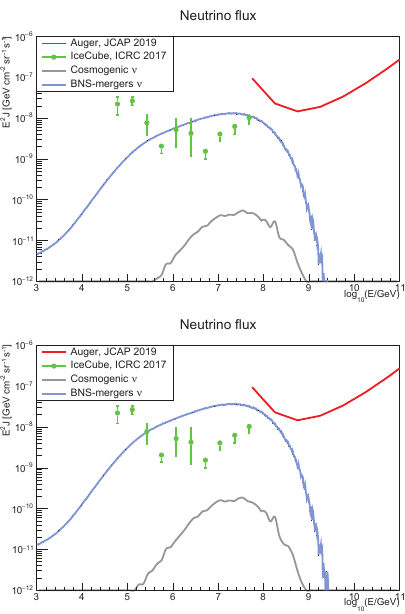
Figure 5. The same of Figure 4, but for the following parameters: = 10 18 . 5 V and m = 0 (top panel); γ = 2 . 1, R γ = 1 . 5, R max 10 18 V and m = 0 (bottom